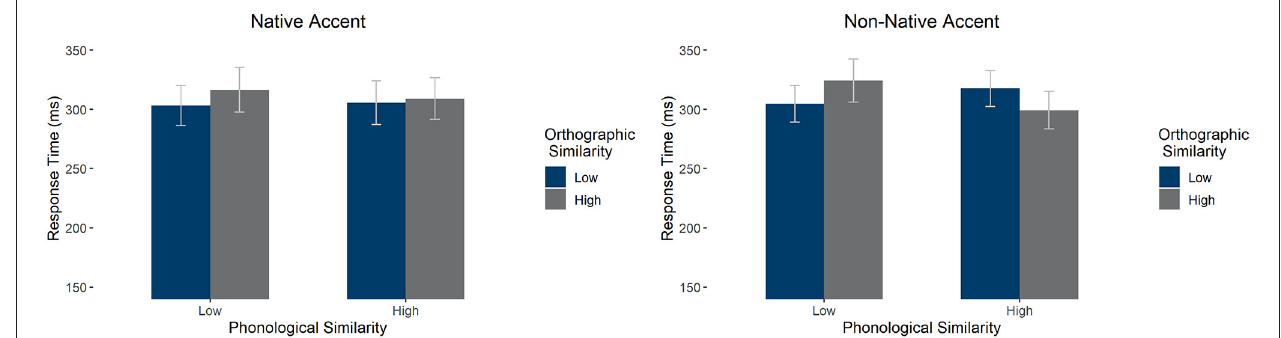
FIGURE 2 | Average response times in the LDT by accent, orthographic similarity, and phonological similarity condition. Error bars mark 95% confidence intervals.